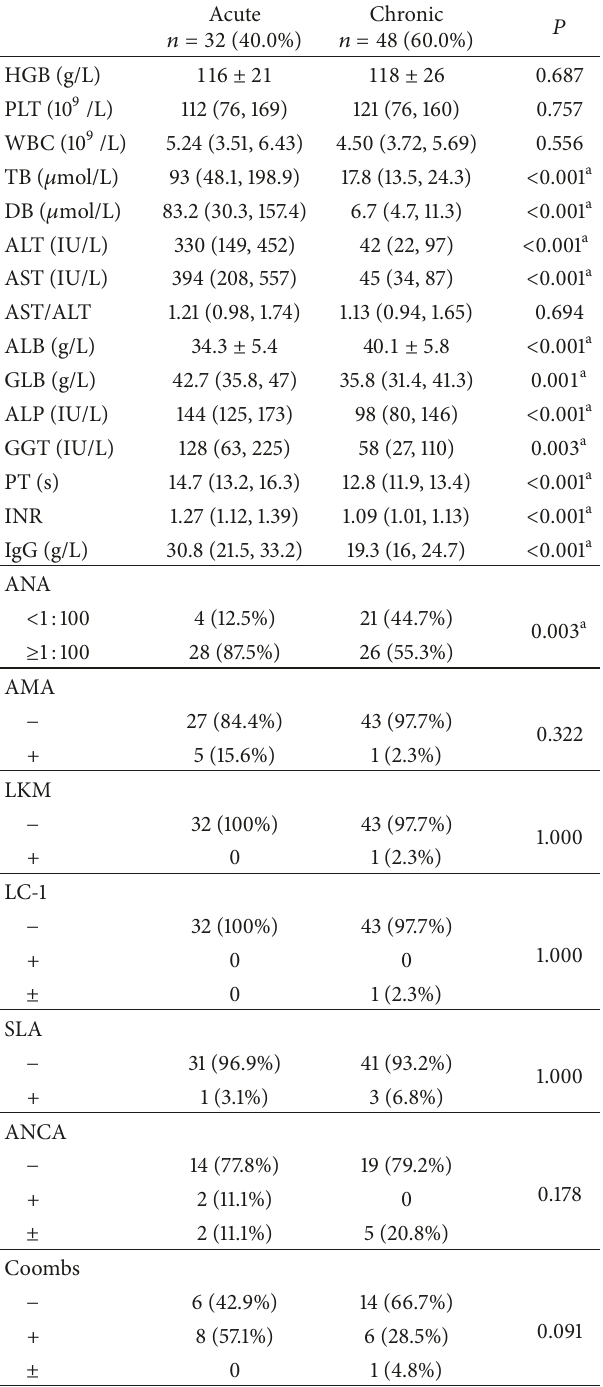
Table 2: Comparison of laboratory data between A-AIH and C-AIH patients.